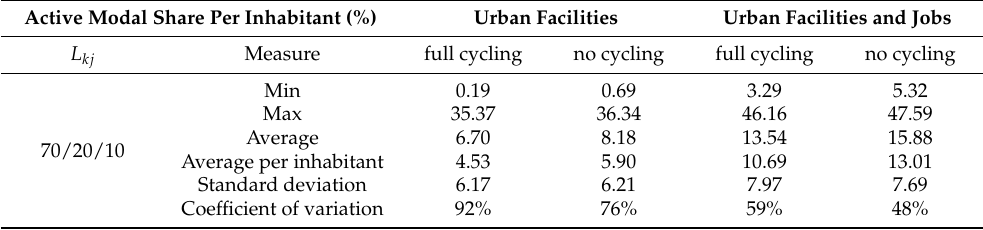
Table 4. Fossil energy spending summarizing